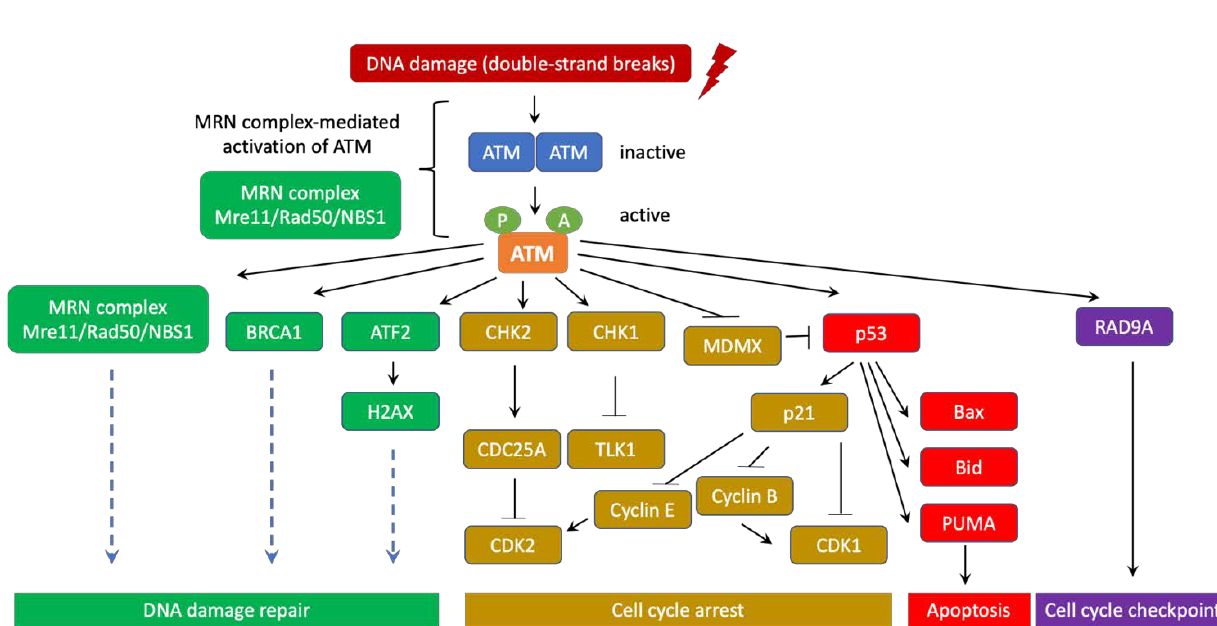
Figure 2. ATM canonical signaling pathway in DNA damage repair, cell cycle arrest and apoptosis. In normal situations, ATM are often inert and form homodimers or polymers. However, when DNA damage occurs, ATM is quickly activated and disassociates into highly active monomers. ATM initiates the DNA-damage response through co-signaling with the MRN (Mre11/Rad50/NBS1) complex at the DNA lesion sites. In fact, direct interaction with the MRN complex induces ATM to phosphorylate a number of downstream targets that are essential for DNA damage repair, cell cycle checkpoint, cell cycle arrest, and apoptosis. During this process, ATM undergoes a series of autophosphorylation on Ser367, Ser1893, Ser1981, and Ser2996 as well as acetylation on Lys3016. Activated ATM is recruited to the DNA damage sites for starting